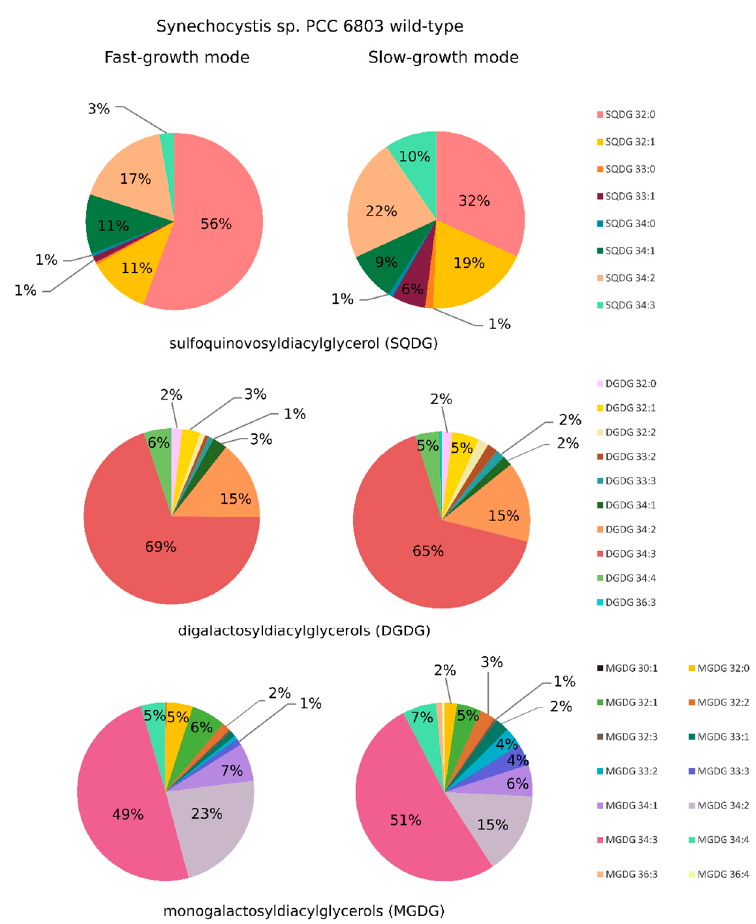
Figure 2. The lipidome of Synechocystis sp. PCC 6803 wild-type strain as determined in this work. Relative amount of lipid species (presented as average percentage) within the classes MGDG (monogalactosyldiacylglycerols), DGDG (digalactosyldiacylglycerols), and SQDG (sulfoquinovosyldiacylglycerol), detected in Synechocystis sp. PCC 6803 wild-type cells cultivated photoautotrophically either in fast-growth mode (FGM) or in slow-growth mode (SGM). For each lipid class, percentages were calculated based on the average peak area of each lipid species, and on the average peak area of the total lipid species within that lipid class. The detailed list of the calculated relative amounts is presented in Table S2.